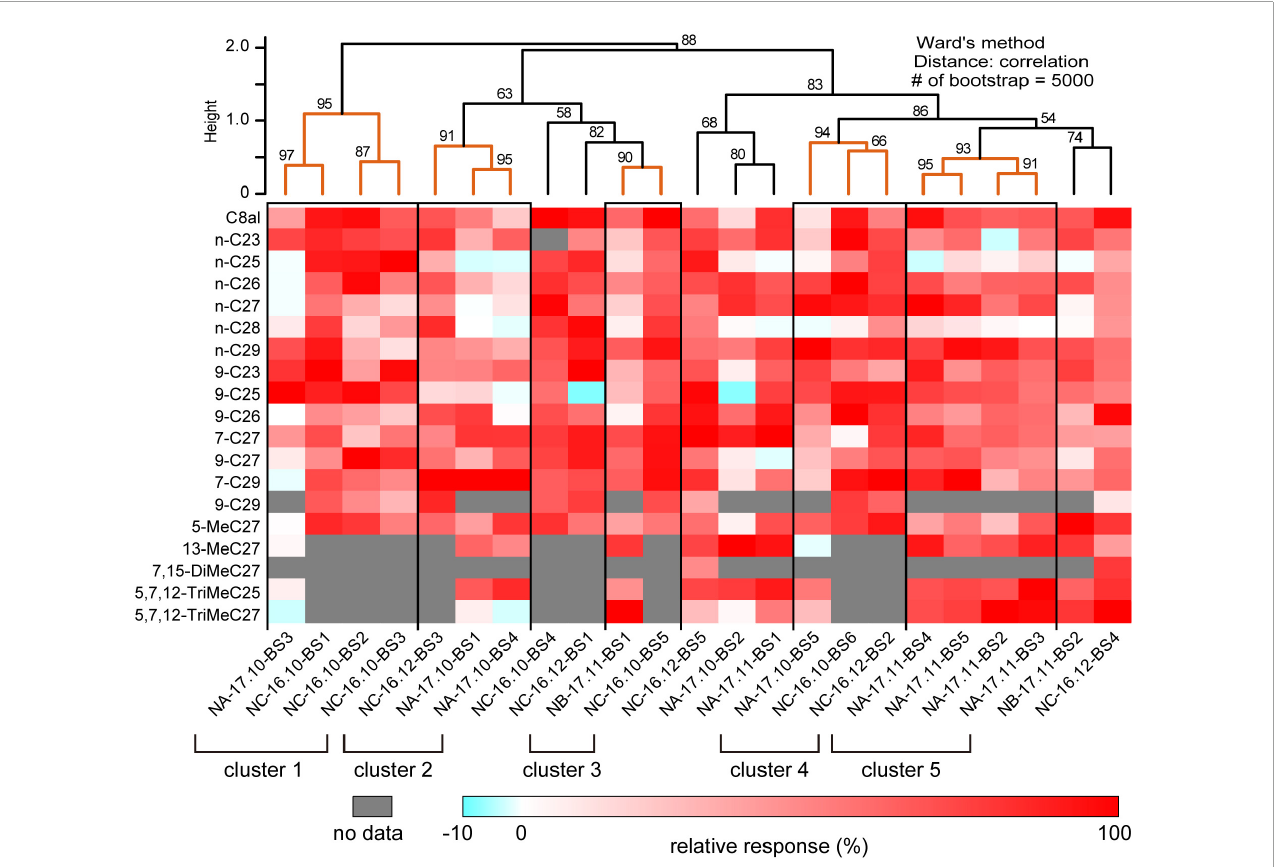
FIGURE2 Cuticular hydrocarbon (CHC) response spectra of 23 basiconic sensilla. The CHC response spectra of 23 basiconic sensilla ( Supplementary Figures 3 – 5 ) are shown as a heat map of relative response intensities. Based on the similarities of CHC response spectra, we performed cluster analysis using Ward’s method, and 23 basiconic sensilla were classified into several groups as shown in the dendrogram. The numbers denoted in the dendrogram indicate the bootstrap P -value (%). We considered that sensilla belonging to the clade whose bootstrap P -value was > 0.90 exhibit similar CHC response spectra. In this study, we identified five groups of basiconic sensilla (clusters